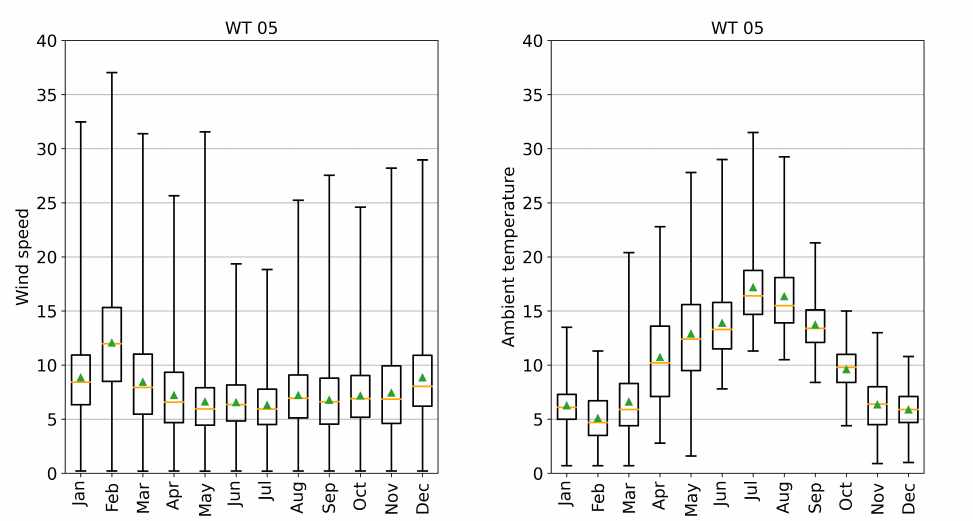
Figure 9. Boxplots representing wind speed ( left ) and ambient temperature ( right ) of an exemplary turbine (WT05) along the